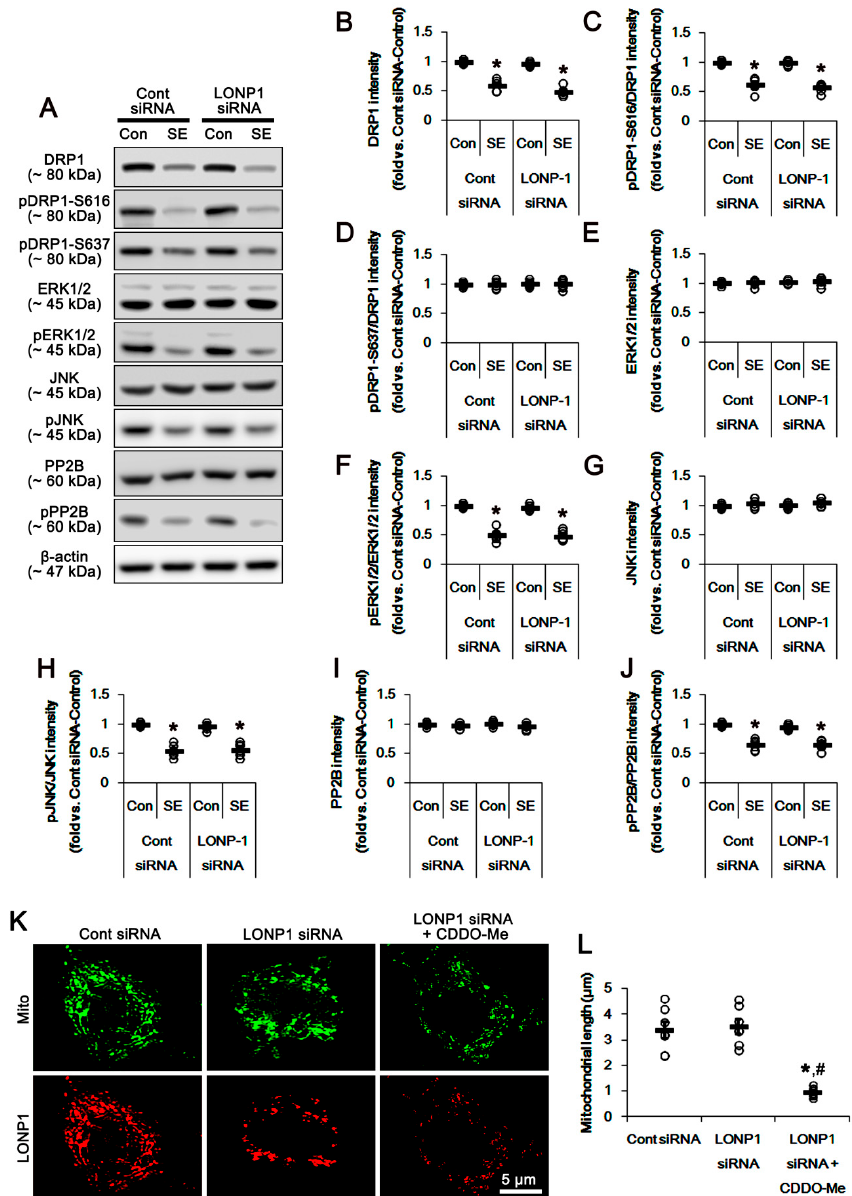
Figure 8. E ff ects of LONP1 knockdown on expression / phosphorylation of DRP1, ERK1 / 2, JNK and PP2B, and mitochondrial length in CA1 neurons. LONP1 siRNA does not a ff ect the expression and phosphorylation levels of DRP1, ERK1 / 2, JNK and PP2B under physiological- and post-SE conditions. In addition, LONP1 knockdown does not influence SE-induced mitochondrial elongation in CA1 neurons, although it reduces LONP1 expression. However, co-treatment of CDDO-Me ameliorates mitochondrial elongation. ( A ) Representative images for western blots of DRP1, phospho (p)-DRP1-S616, pDRP1-637, ERK1 / 2, pERK1 / 2, JNK, pJNK, PP2B and pPP2B in the hippocampal tissues. ( B – J ) Quantifications of DRP1, pDRP1-S616, pDRP1-637, ERK1 / 2, pERK1 / 2, JNK, pJNK, PP2B and pPP2B levels. Open circles indicate each individual value. Horizontal bars indicate mean value. Error bars indicate S.E.M. (* p < 0.05 vs. control animals; n = 7, respectively). ( K ) Representative photos of mitochondria (Mito) and LONP1 in CA1 neurons following SE. ( L ) Quantification of the mitochondrial length in CA1 neurons. Open circles indicate each individual value. Horizontal bars indicate mean value. Error bars indicate S.E.M. (* ,# p < 0.05 vs. control siRNA and LONP1 siRNA, respectively; n = 7,